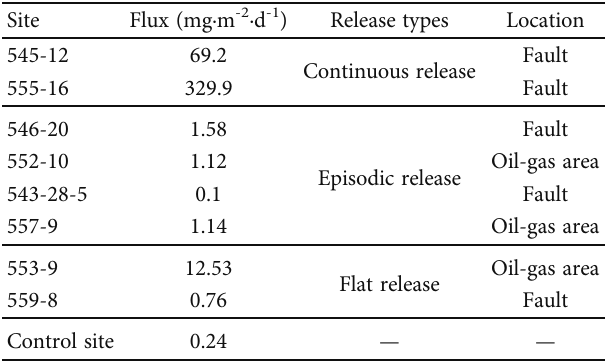
Figure 7: Episodic release: (a) 546-20; (b) 552-10; (c) 543-28-5; (d) 557-9. Table 1: CH microseepage fl uxes and release types of some 4 sampling points in the Dawanqi oil fi eld.